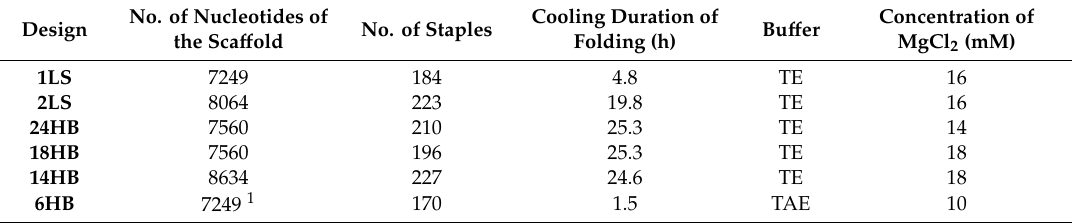
Table A1. Experimental details of the DNA nanoparticle synthesis via DNA origami (respective sca ff old, number of staples, thermal treatment, bu ff er and salt concentration used for the folding procedure).